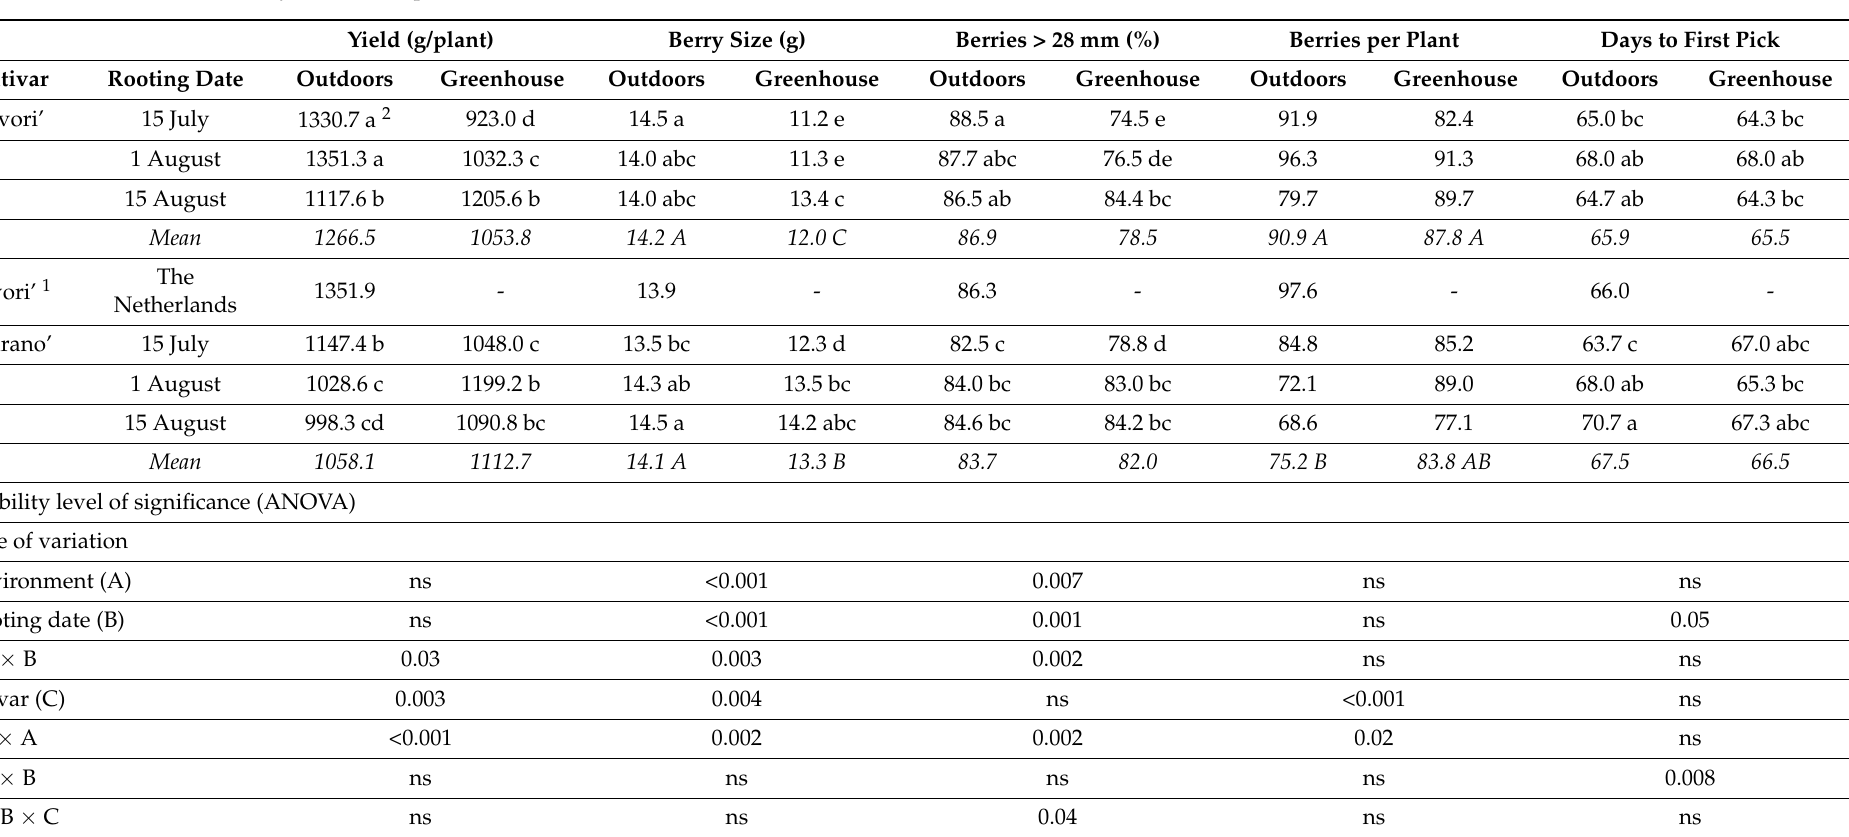
Table 2. Effects of rooting date and raising environment on yield performance of two everbearing strawberry cultivars cropped in a table-top system in an unheated plastic tunnel in the year after treatment. Results for imported ‘Favori’ plants are included for comparison. The data are means of three replicates, each with three trays with three plants